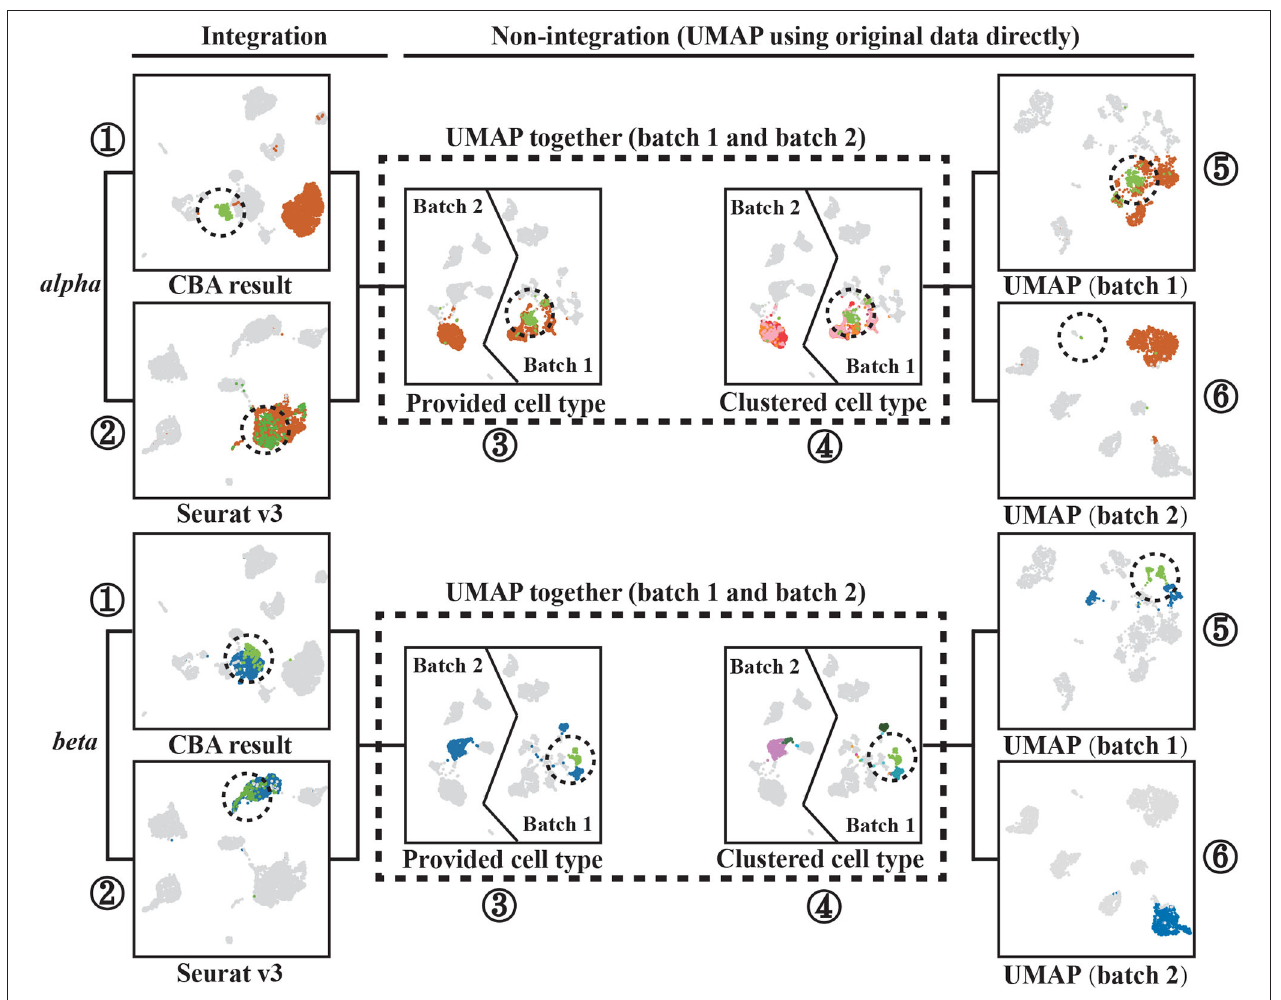
FIGURE 4 | Two cell types, alpha and beta cells, tracked through different alignment spaces, i.e., UMAPs of: (1) the CBA alignment, (2) the Seurat v3 alignment, (3) and (4) the two batches together but with unaligned cells, (5) only cells in batch one, and (6) only cells in batch two. Alpha or beta cells are colored the remaining cells are gray colored cells. Encircled Alpha cells are colored with light green to track them in all plots. Separated beta cells in batch one are also circled and colored with light green to track them in all plots. Notably, cells are colored according to provided cell types in all plots except (4), these cell types are corresponding with Figure 2 and they are not used when clustering in CBA. In (4), cells are colored according to how they are clustered in the original dataset (using the initial Louvain